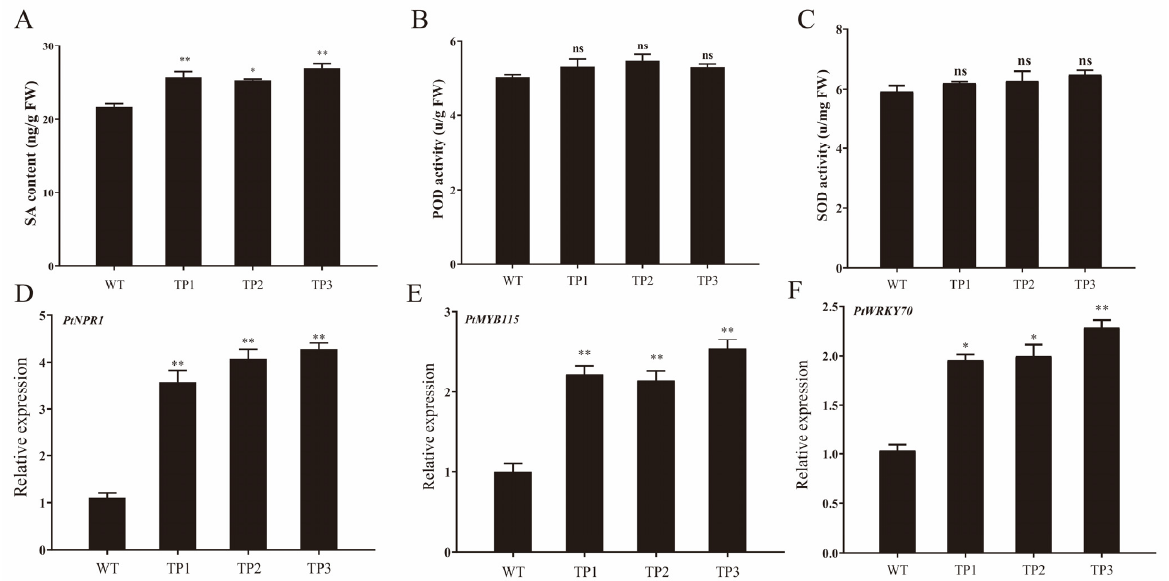
Figure 6. Overexpression of OsCYP85A1 enhanced plant disease resistance. ( A ) Salicylic acid (SA); ( B ) Superoxide dismutase (SOD); ( C ) Peroxidase (POD). Expression of genes related to poplar disease resistance. The expression level of these genes in the stem of WT was set to 1. ns, nonsignificant; Error bars represent the SDs from three biological replicates. * and ** indicate significant differences in comparison to WT at p < 0.05 and p < 0.01, respectively (Student’s t -test).